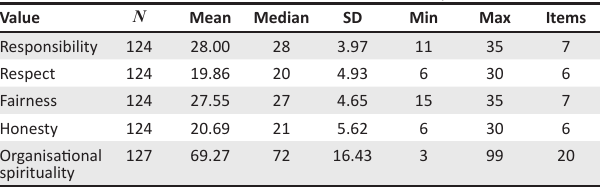
TABLE 1: Data on levels of scores of ethical behaviour components measured.